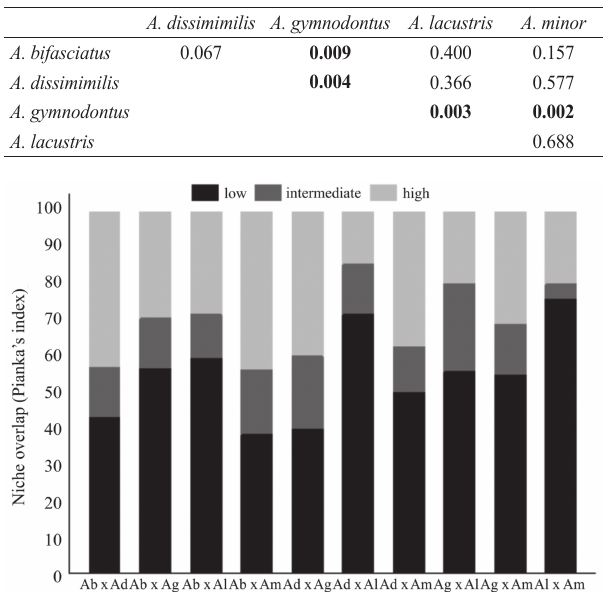
Fig. 3. Variation in diet breadth based on 40 food items consumed by five Astyanax species in the Low Iguaçu River and tributaries in Brazil. Diet breadth was evaluated by dispersion of the diet of species in the multivariate space by using PERMDISP (large spatial distance from the centroid indicates wide dispersion, i.e. , wide trophic breadth). Lower and upper bars of the box represent 25 and 75 quartiles, respectively. The horizontal bar within each box represents the mean diet breadth. Tab. 3. P -values of PERMDISP analyses of the diet breadth of five Astyanax species in the Low Iguaçu River and its tributaries in Brazil.